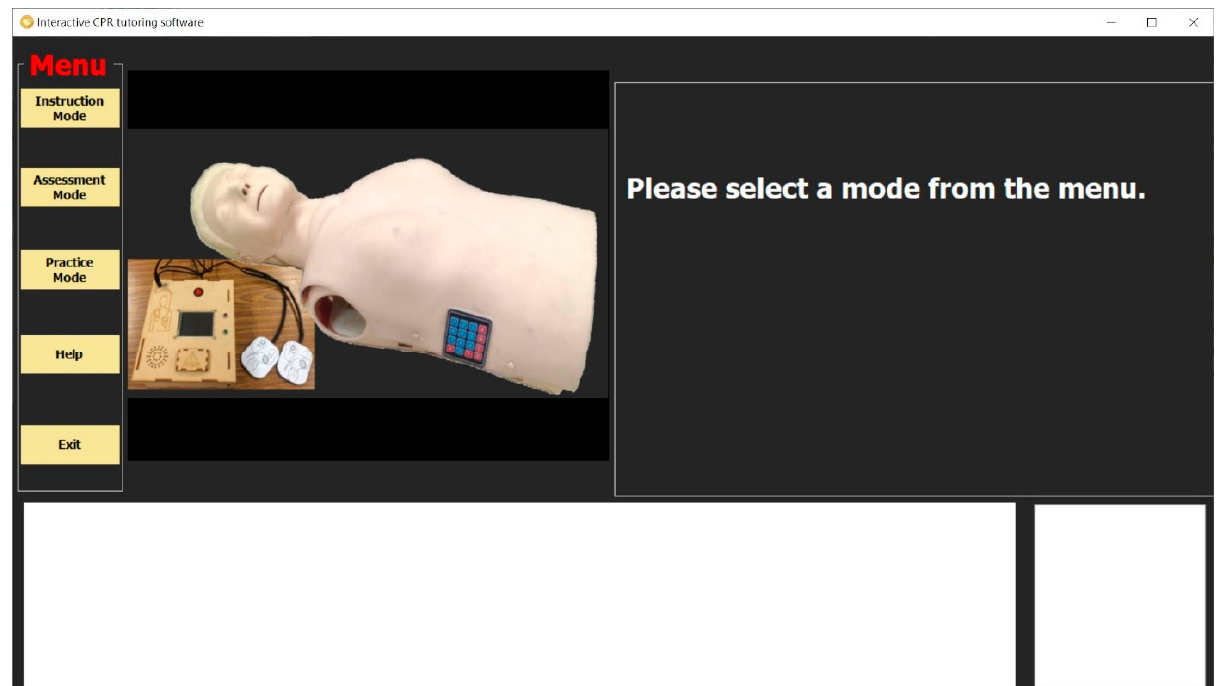
Figure 10. The interactive CPR tutoring software.